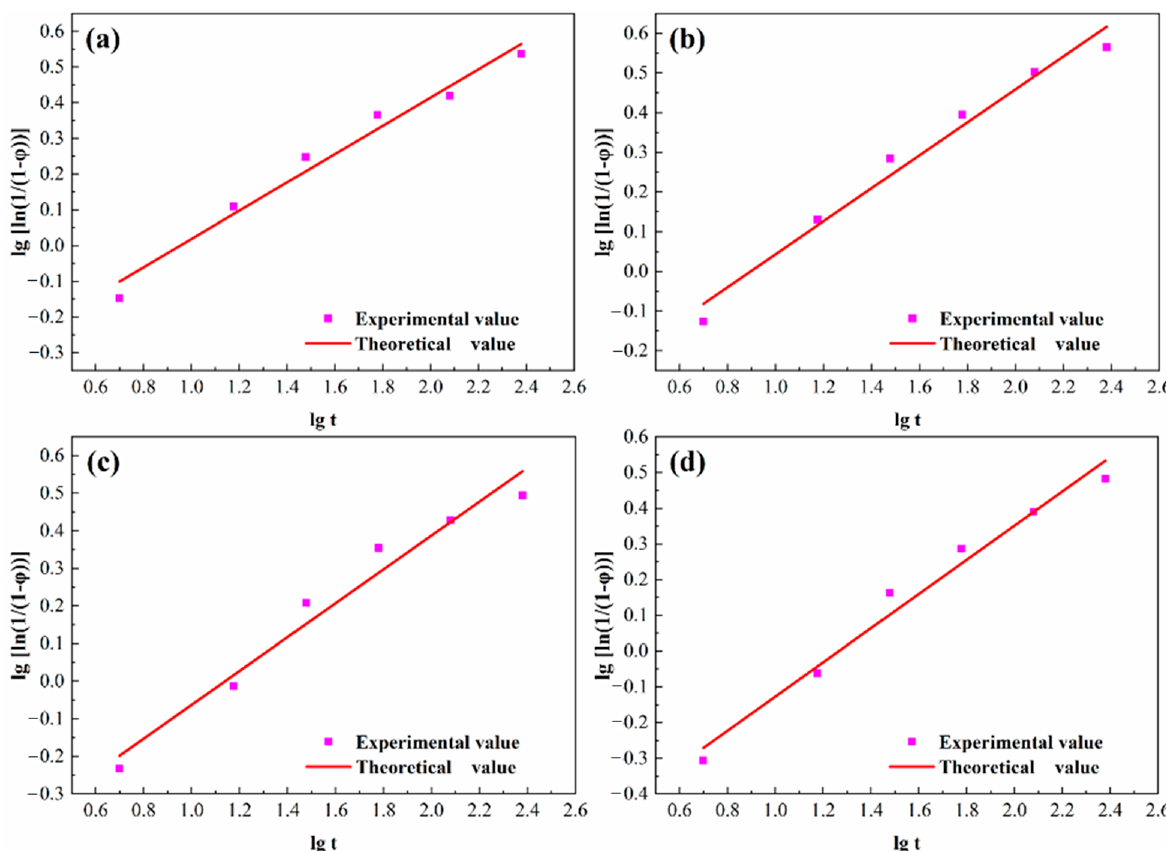
Figure 9. Fitting curve of precipitation phase conversion and aging time. ( a ) NC-1 alloy; ( b ) NC-2 alloy; ( c ) NC-3 alloy; ( d ) NC-4 alloy. Table 8. The phase transition equation of alloys at 500 °C.